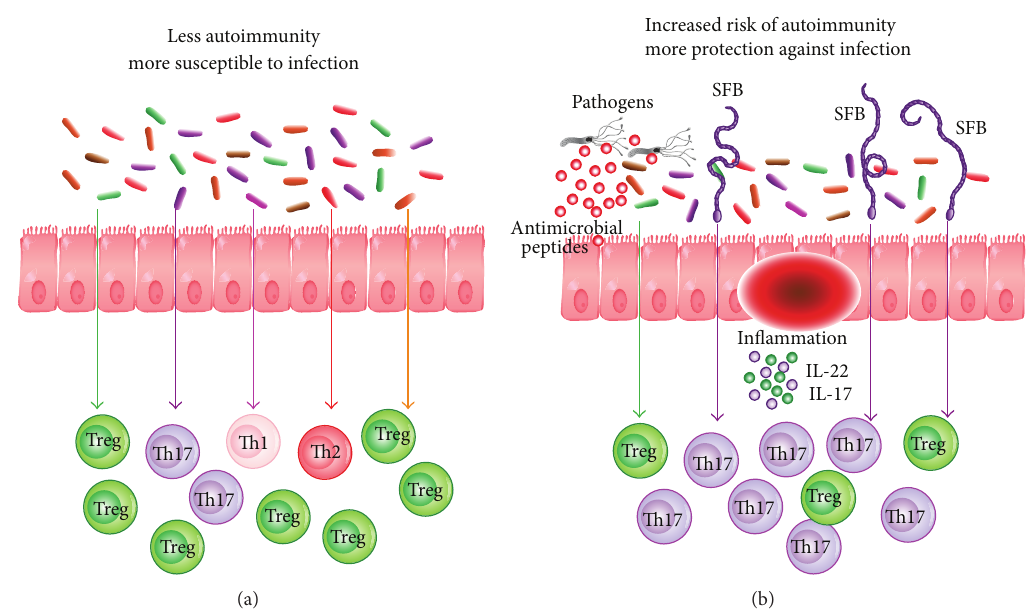
Figure 2: The composition of the intestinal microbiota is involved in the regulation of immune homeostasis. (a) Signals from different components of the microbiota (different colored arrows) regulate different branches of mucosal T cell response (corresponding color immune cells) in the lamina propria. (b) Changes in the composition of commensal bacteria, for example, the introduction of segmented filamentous bacteria (SFB), effect a change in the immune homeostasis, in this case, increasing the signals mediating induction of Th17 cells (purple arrows). This changes the immunological fitness of the individual. In the case of SFB, the increased production of Th17 cell effector cytokines, for example, IL-17 and IL-22, and the consecutive increase in antimicrobial peptide production from epithelial cells (red circles) increase the ability of the host to fight off intestinal infections. However, this increase in proinflammatory cytokines may also render the host more susceptible to chronic autoimmune inflammation. In this way, differences in the composition of the commensal bacteria in the gut may account for differences in individual response in the face of similar environmental challenges. (Adapted from: Ivanov I, Littman D. Segmented filamentous bacteria take the stage. Mucosal Immunology, 3(3):209-12,